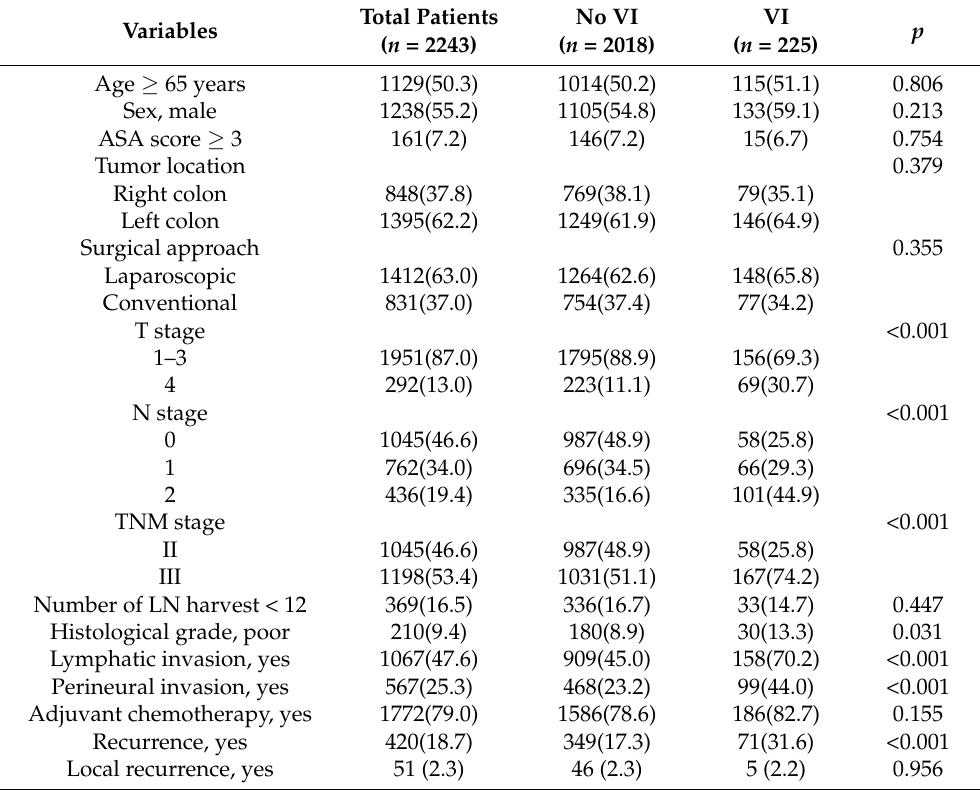
Table 1. Baseline characteristics according to vascular invasion (VI)